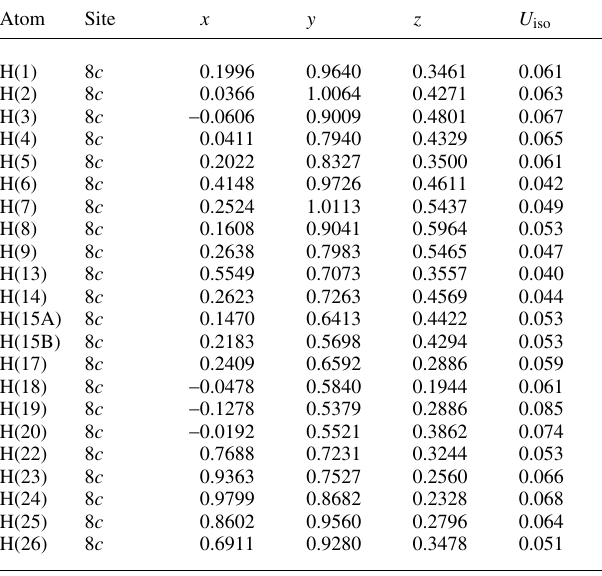
Table 2. Atomic coordinates and displacement parameters (in Å 2 )